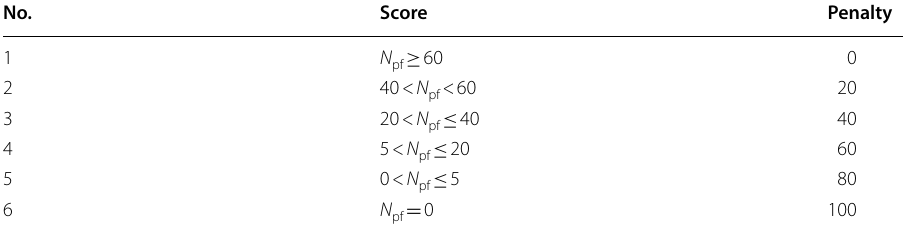
Table 6 Civil aviation passenger record penalty standard No.